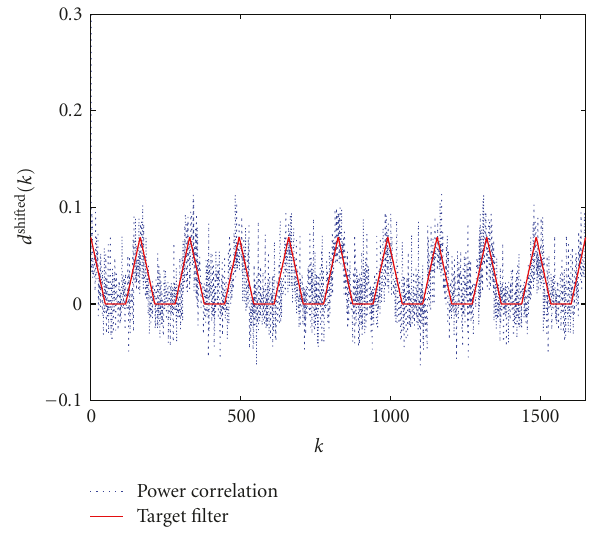
Figure 9: Power autocorrelation of a ZP-OFDM signal and its estimated target filter through CM-4 channel models with AWGN at SNR = 0dB.